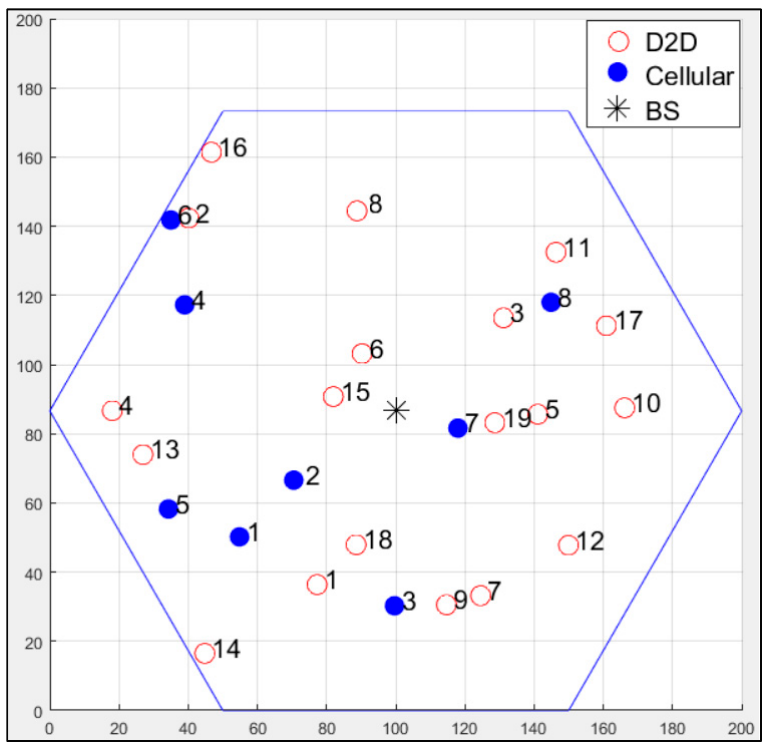
Figure 4. Proposed model with BS, DUEs, and CUEs.